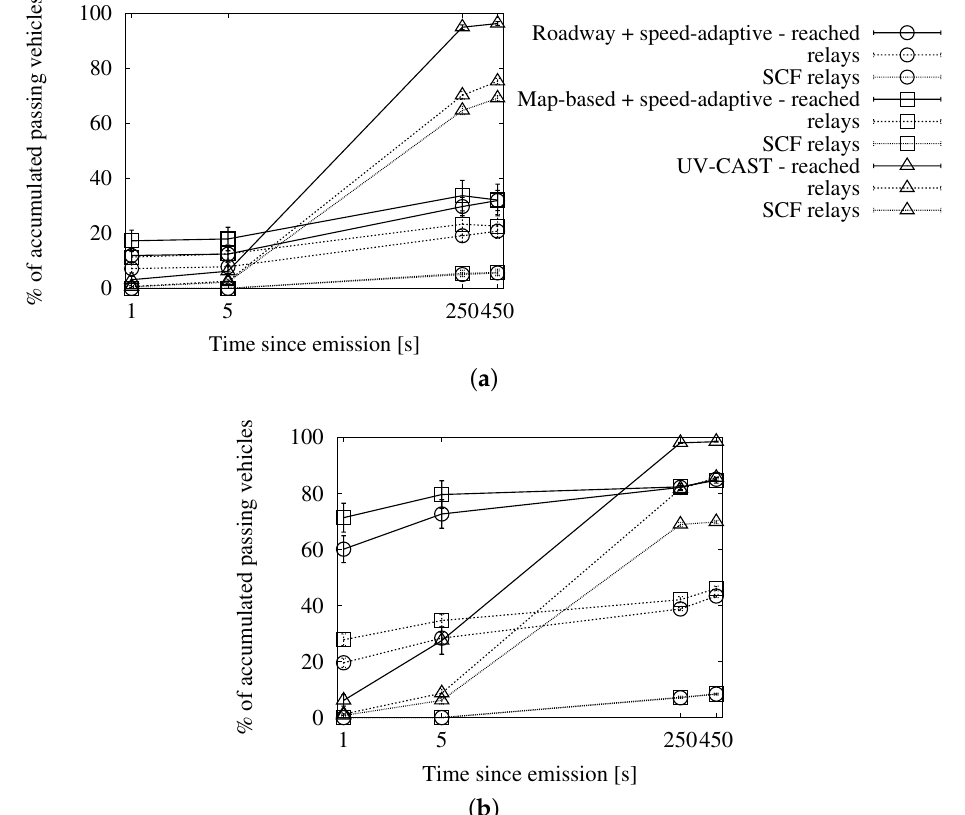
Figure 16. Involved vehicles in comparison with UV-CAST in the New York scenario: ( a ) 25 vehicles/km 2 ; ( b ) 100 vehicles/km 2 .